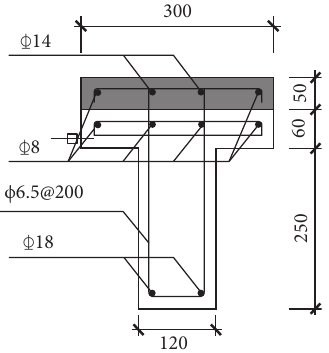
Figure 6: Reinforcement of the cross section at the midspan.